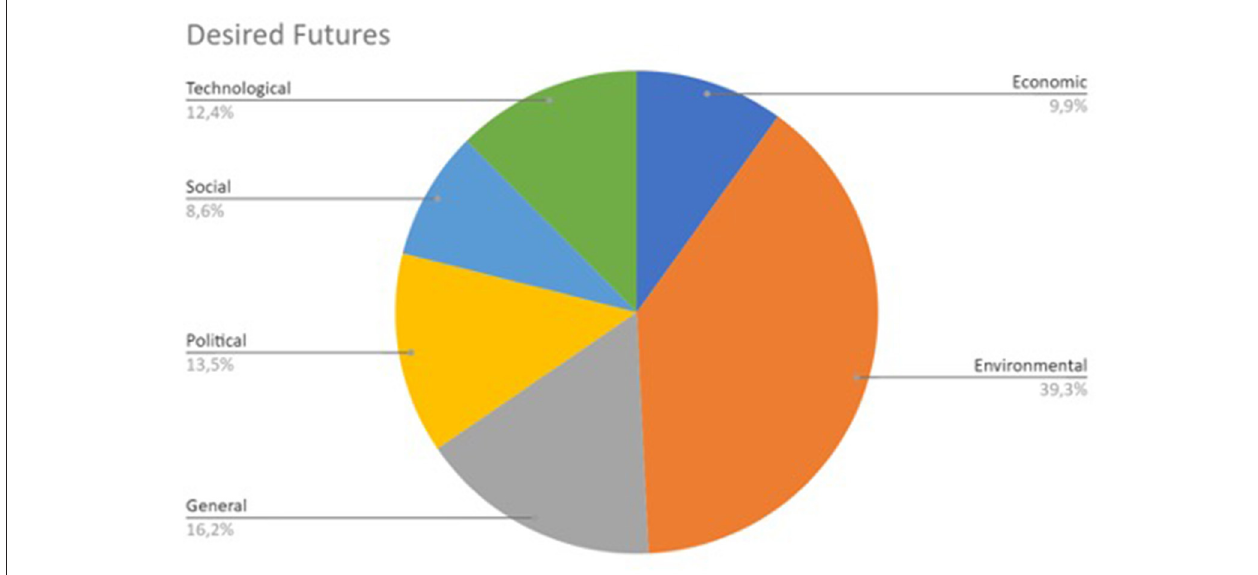
FIGURE 1 | Visualizing the different types of desired futures, and the topic: economic, environmental, social, political, general, and technology.